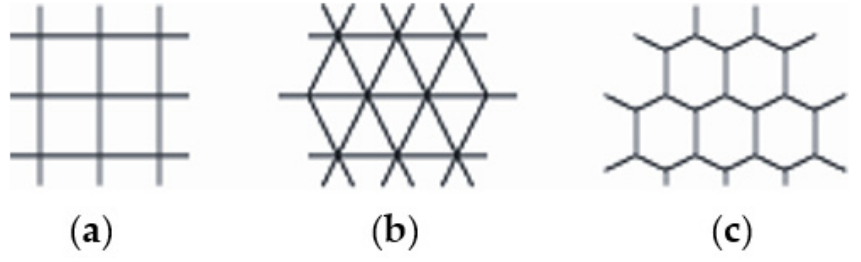
Figure 1. Different type of areas: ( a ) lattice; ( b ) hexagonal; and ( c ) hive.